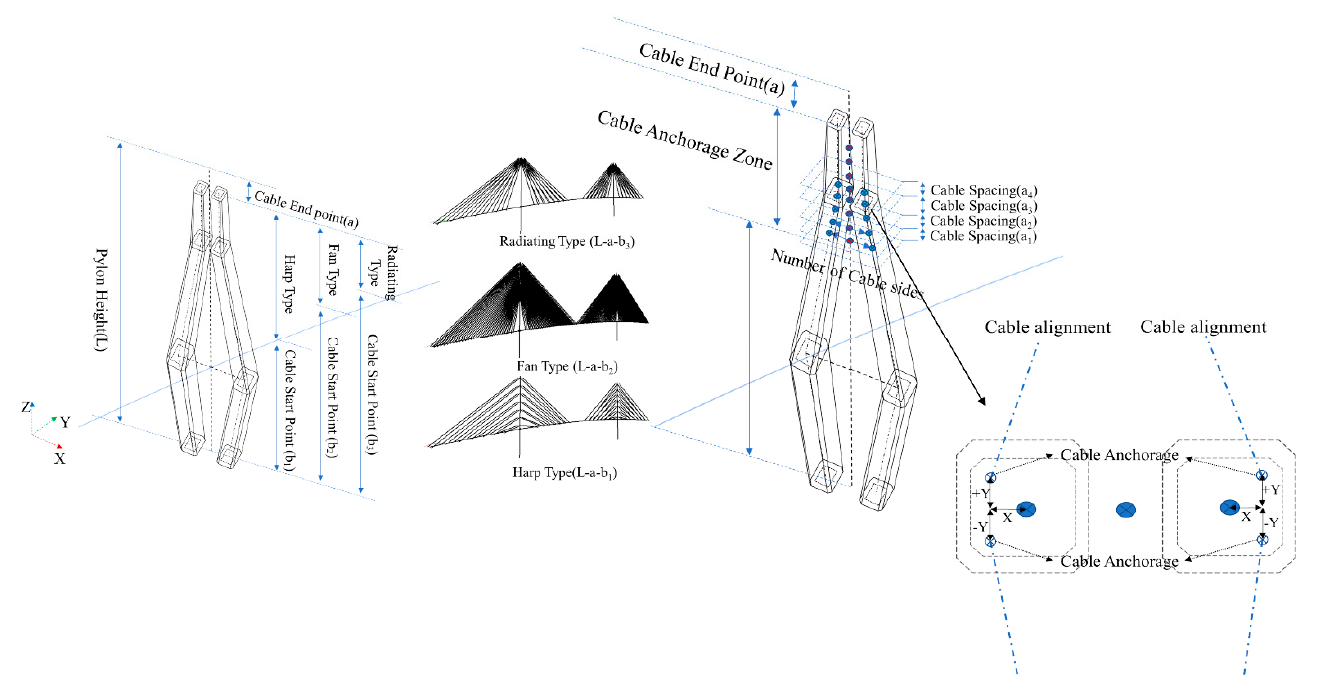
Figure 7. Alternative design algorithm of cable arrangement.